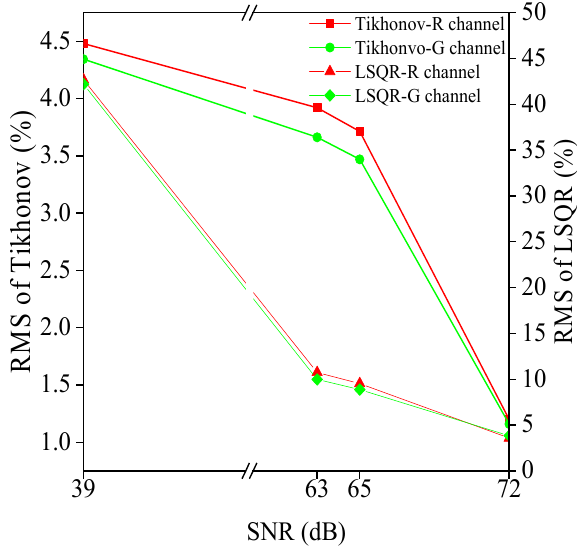
Figure 10. Influence of different intensity noises on the reconstruction accuracies of the two algorithms.